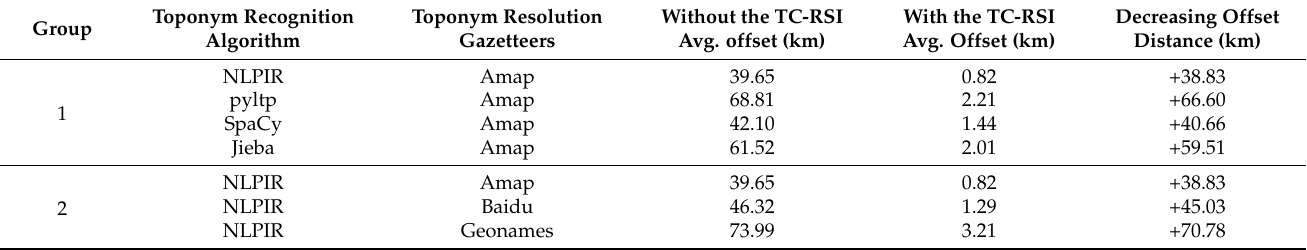
Table 5. Results of robustness assessment of the TC-RSI method by different toponym recognition algorithms and toponym resolution